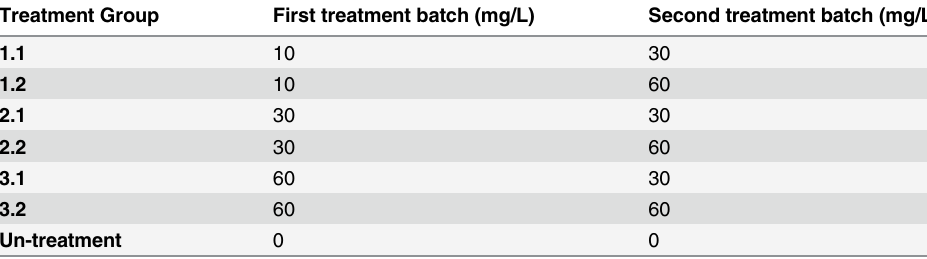
Table 1. The concentration of cefradine in the first and second treatment batches. Treatment